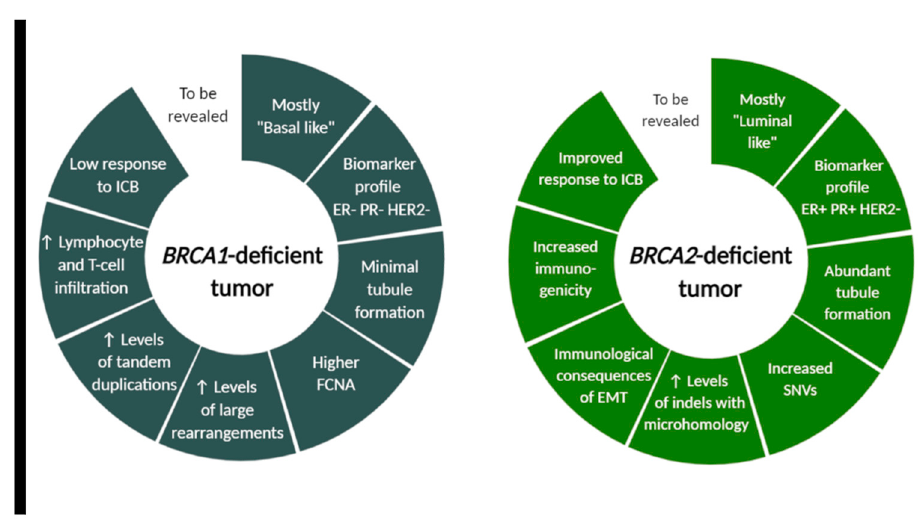
Figure 2. BRCA1 - and BRCA2 -deficient tumor characteristics differ in morphological, molecular and immunological features. Although many tumor cell-intrinsic differences between BRCA1 and BRCA2 -associated cancer were revealed, this field still warrants further investigation for successful design of future clinical trials. FCNA (fraction copy-number alterations), ICB (immune checkpoint blockade), SNVs (single-nucleotide variants), indels (insertions and deletions), EMT (epithelial-to-mesenchymal transition). Created with BioRender.com.